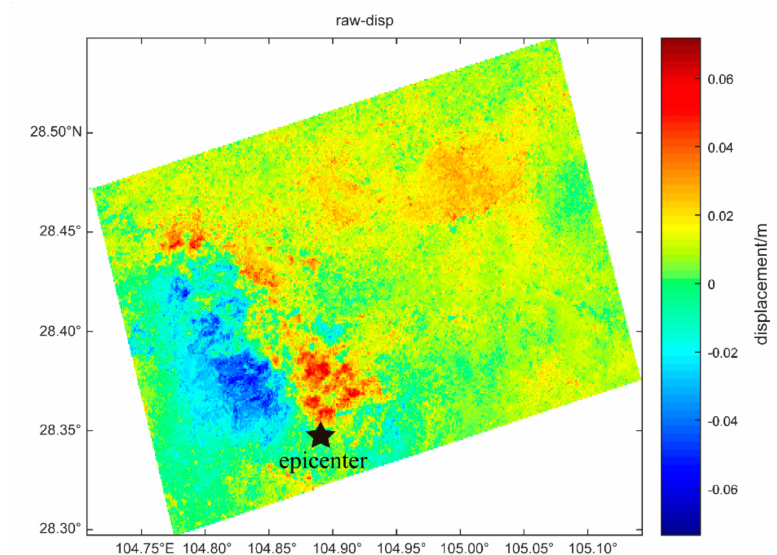
Figure 5. InSAR co − seismic deformation for the area of interest, corresponding to Figure 1. The red rectangle represents the area of interest; the black pentagram represents the earthquake location ac- cording to the China Earthquake Networks Center; the color − coded strip represents the displacement of co-seismic deformation for InSAR.